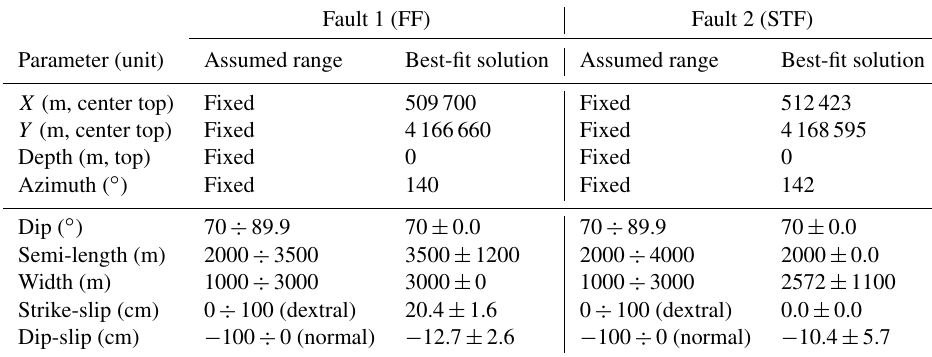
Table 2. Best fitting range for the model.